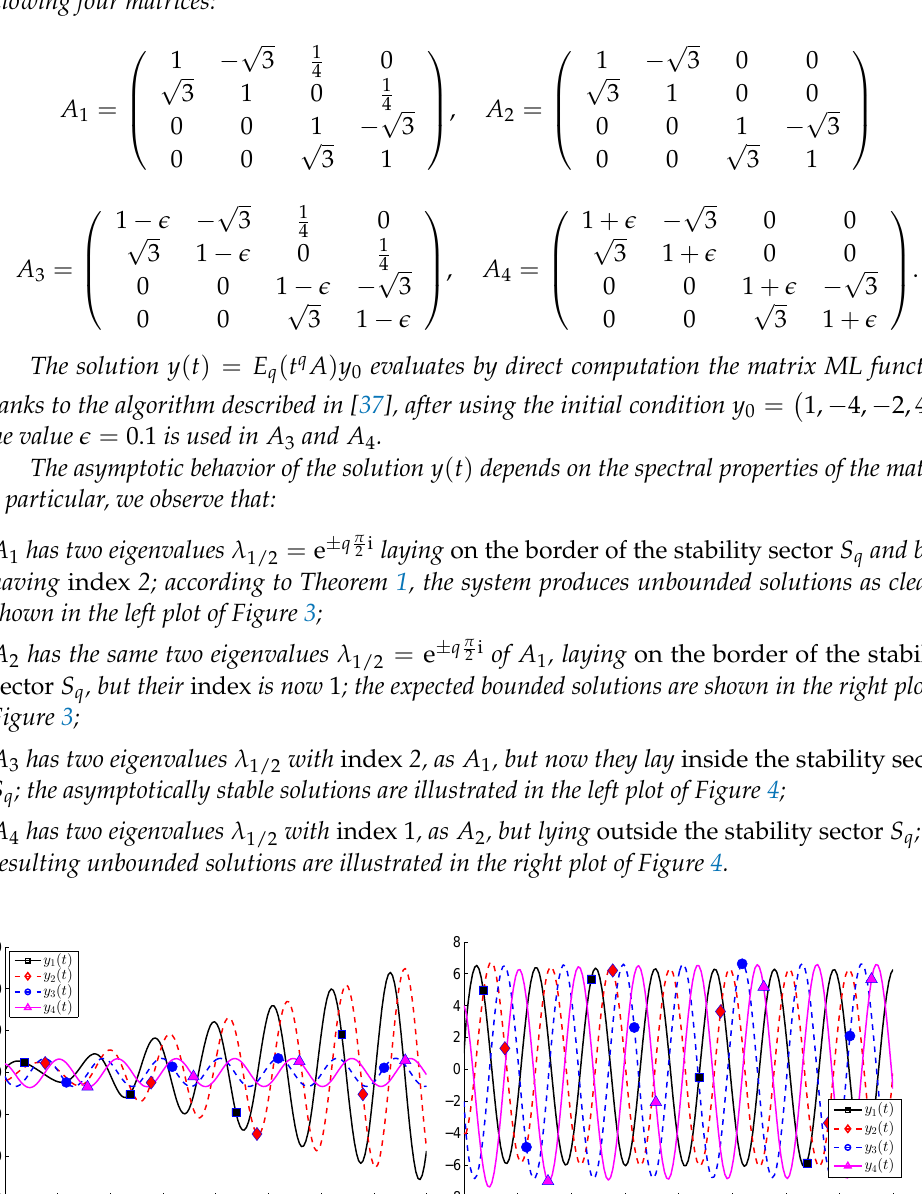
Figure 3. Solutions of the linear system C D q A = A 2 ( right